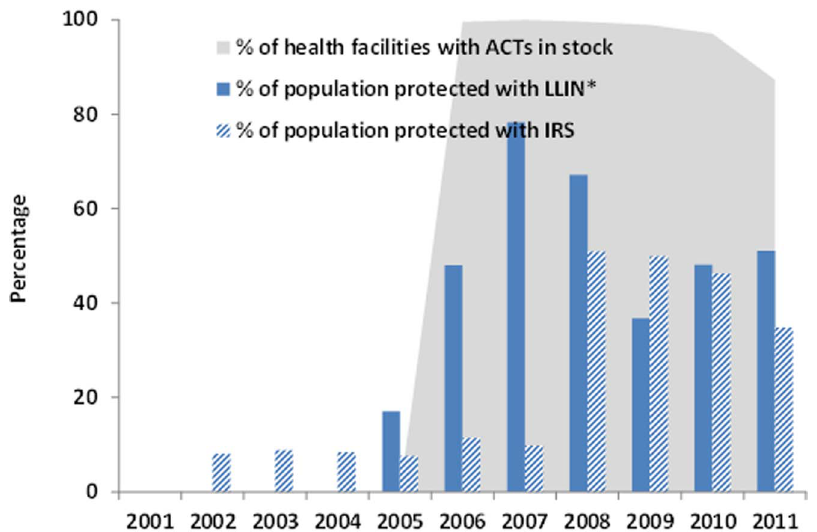
Figure 3. Percentage of population potentially protected with LLINs*, IRS and percentage of health facilities with stock of ACT available by year, 2001–2011, Ethiopia (*number of LLINs distributed during the 3 year period 6 1.8/population).